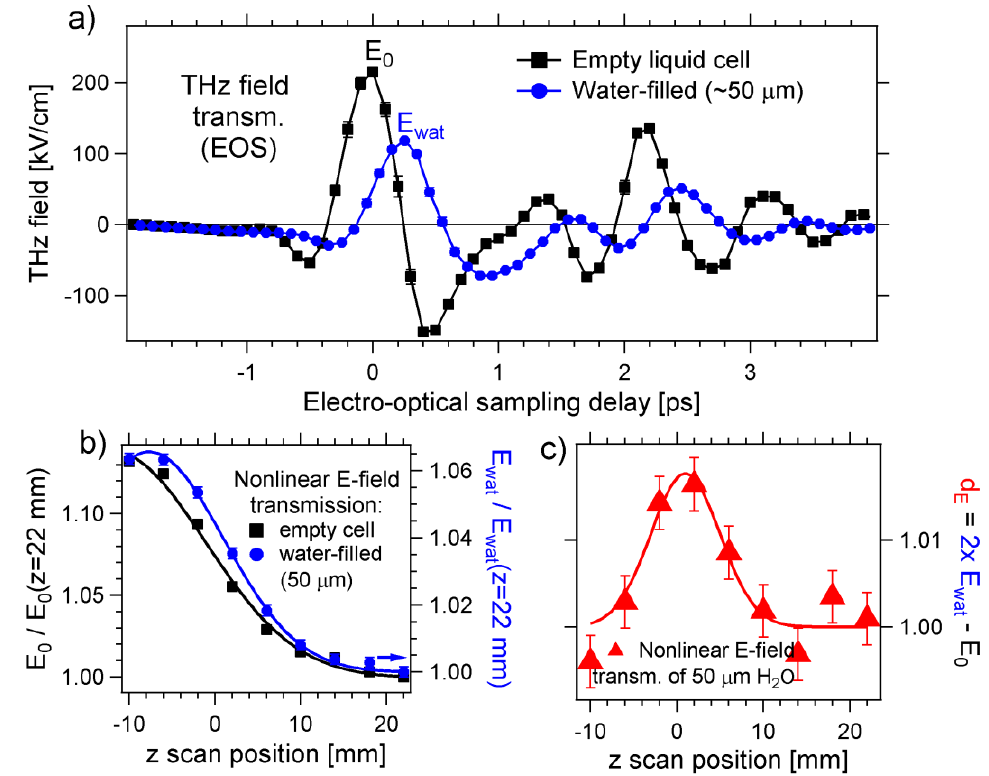
Figure 3. ( a ) We used a 100 µ m ZnTe crystal to detect the THz field transmitted by the empty cell holder (black), and by the sample holder filled with a 50-micron thick layer of pure water (blue). The peak THz field transmitted by the empty (water-filled) cell is marked with E 0 (E wat ). ( b ) Z scan measurements of the peak field transmission of the empty diamond cell (black), and of the liquid cell filled with a 50-micron thick water layer (blue). The error bars are indicated and correspond to the standard error of the mean calculated from 100 measurements. Solid circles and squares represent the experimental results. Solid lines are guides to the eye. ( c ) The nonlinear field transmission of the water layer is estimated to the di ff erence of the field transmissions of filled and empty cells (d E ). The red solid line is a Gaussian fit. The experiments in Panels b–c are performed with a field detector (EOS). In order to compare the electric field transmitted by the filled and empty cell, the field is in each case normalized to the value of the transmission at low THz power, E(z = 22 mm). As shown